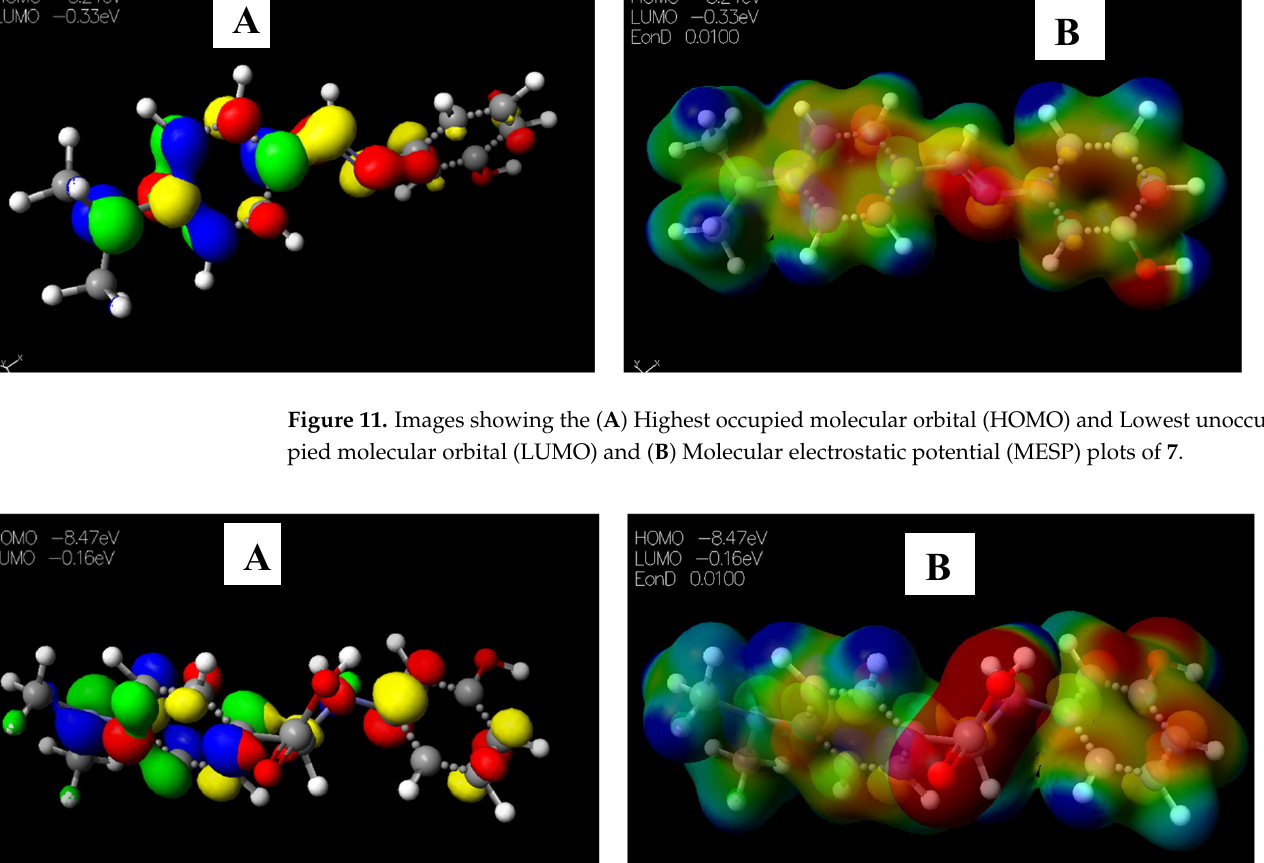
cupied molecular orbital (LUMO) and ( B ) Molecular electrostatic potential (MESP) plots of 6.